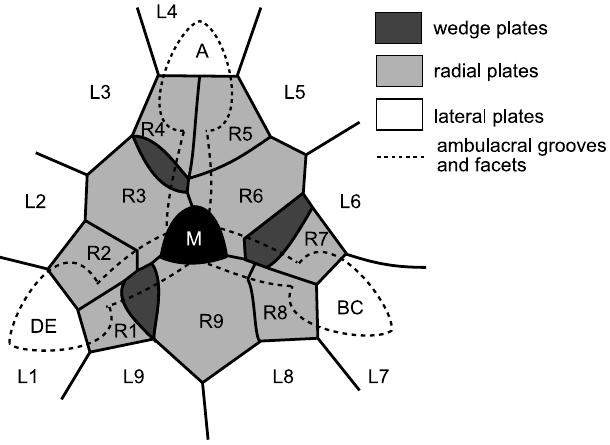
Fig. 21. Oral area of the hemicosmitoid Hemicosmites pyriformis Buch, 1846, Middle Ordovician, Russia. Three ambulacra, interpreted as A, shared BC, and shared DE, converge on the mouth (M) and are surrounded by a circlet of nine radial plates (R1–R9) outside which is another circlet of nine lateral plates (L1–L9). Three wedge plates occur immediately clockwise of radial plates R3, R6, and R9. The hydropore (not shown) occurs in the adoral part of radial 9. In life, biserial cover plates would have roofed over the food grooves. Redrawn and relabelled from Bockelie 1979: 375,